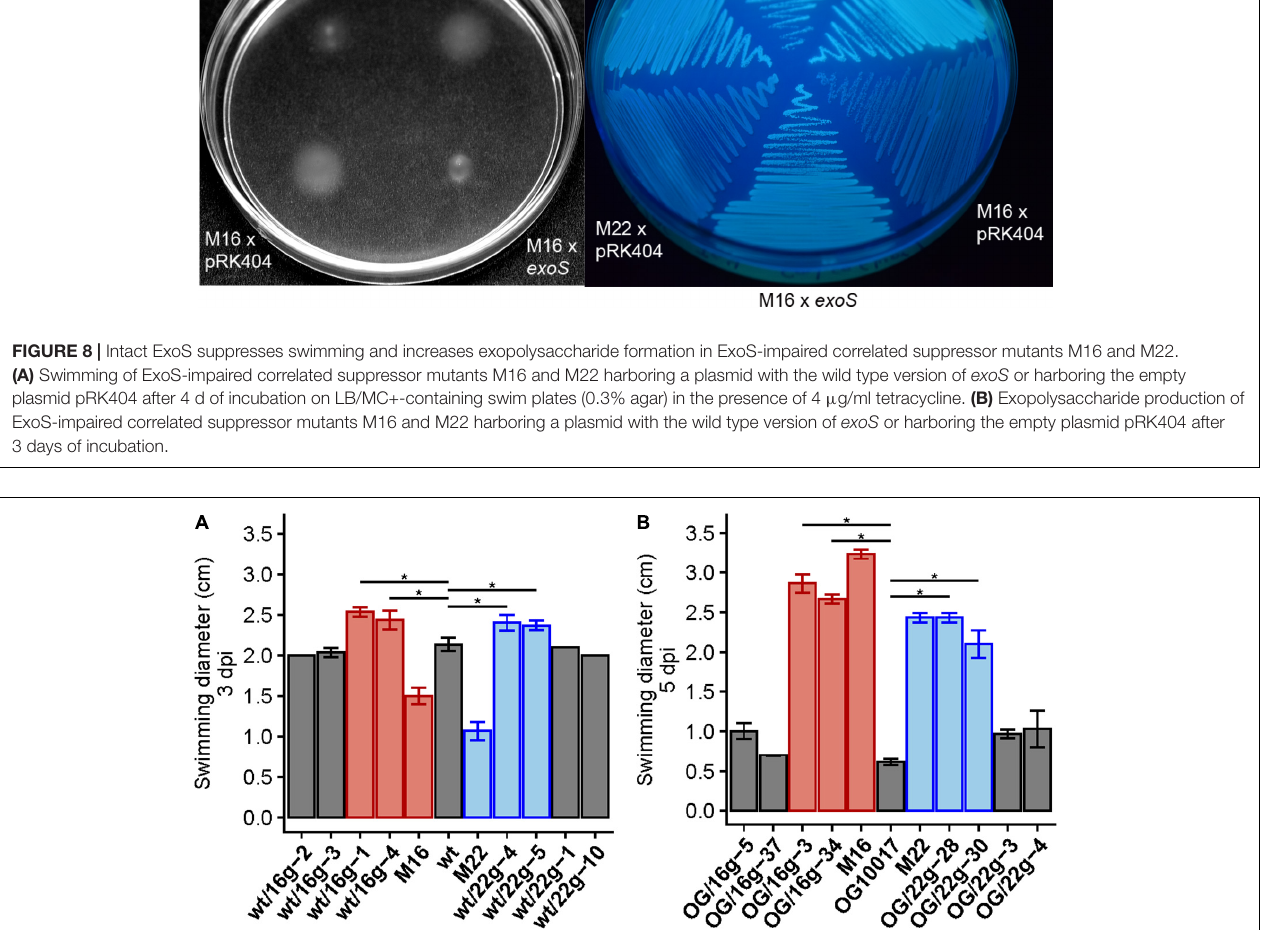
conformational changes that lead to the activation of the ExoS cytoplasmic